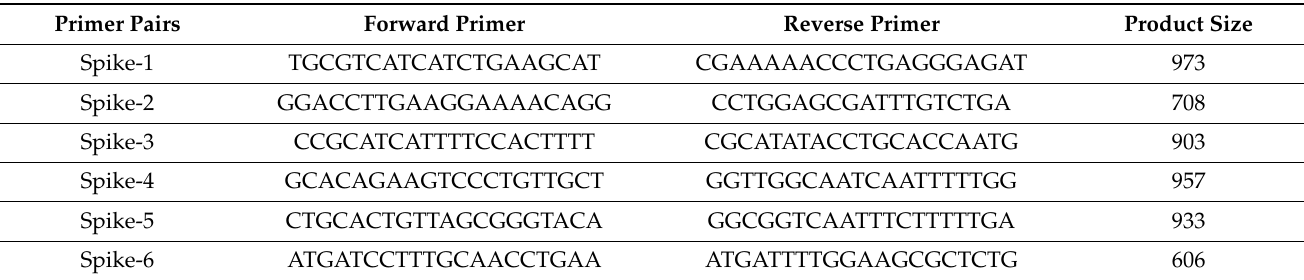
Table 1. Polymerase Chain Reaction (PCR) primers used for spike genome amplification based on the reference genome of SARS-CoV-2 isolate Wuhan-Hu-1 (NC_045512.2). Primer Pairs Forward